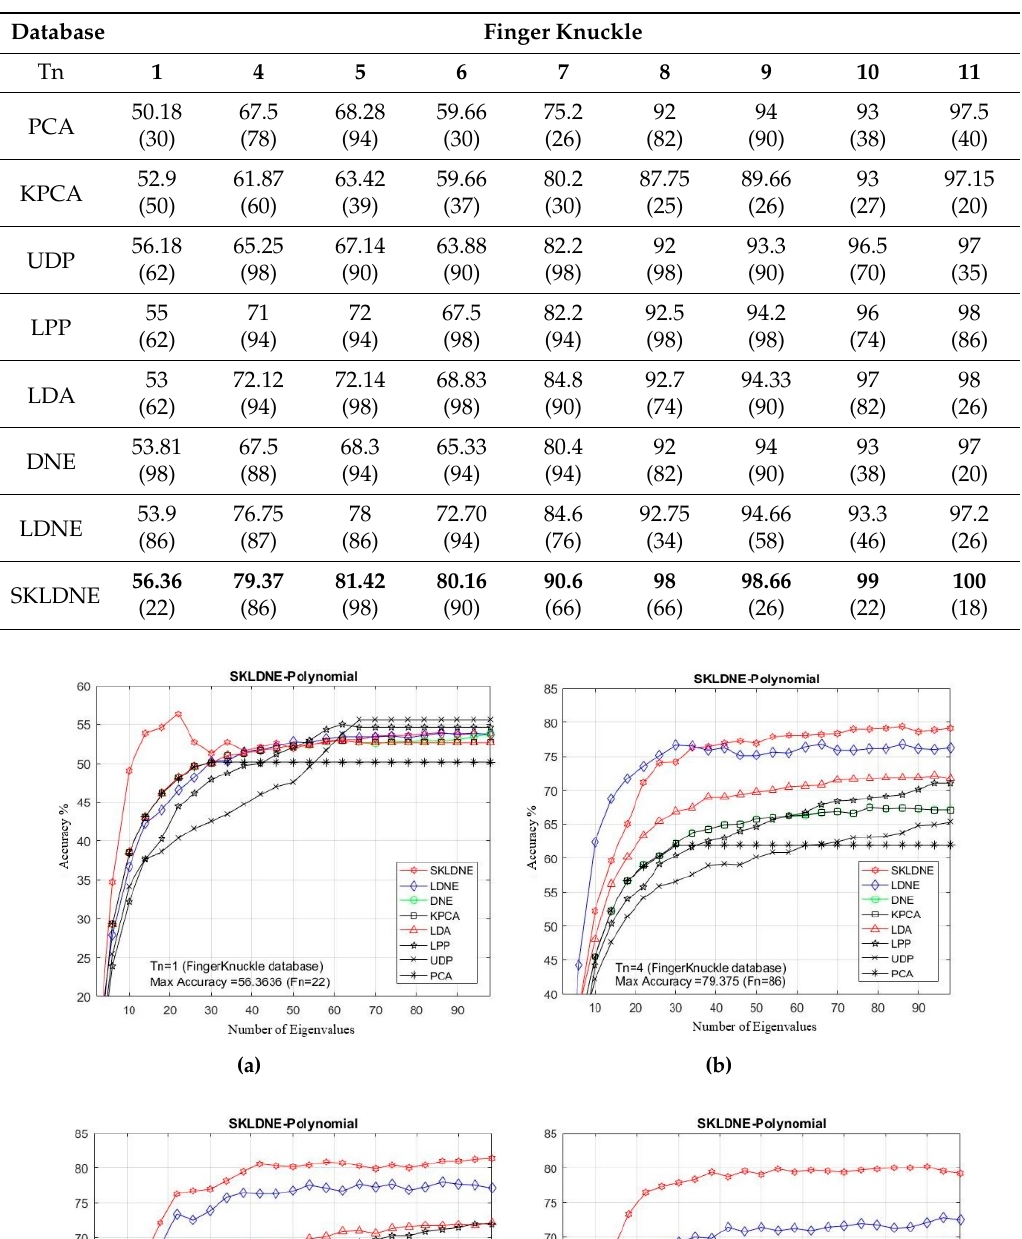
Table 6. Maximum recognition accuracies (in percentage terms) of SKLDNE and other methods for the different number of training and testing images on Finger Knuckle database and corresponding dimensions (shown in parentheses).